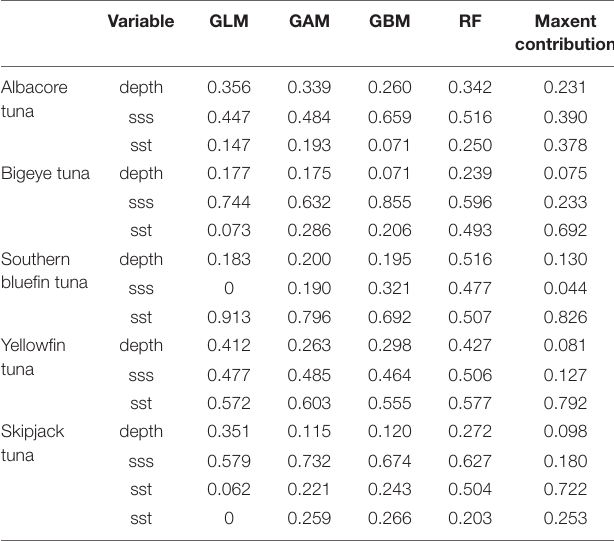
FIGURE 6 | The habitat suitability for skipjack tuna from Maxent in the South Atlantic for the present day and the change to 2080 under RCP4.5 and RCP8.5. The EEZs are shown in the black outline. The yellow areas are the most suitable, and the dark blue the least suitable.